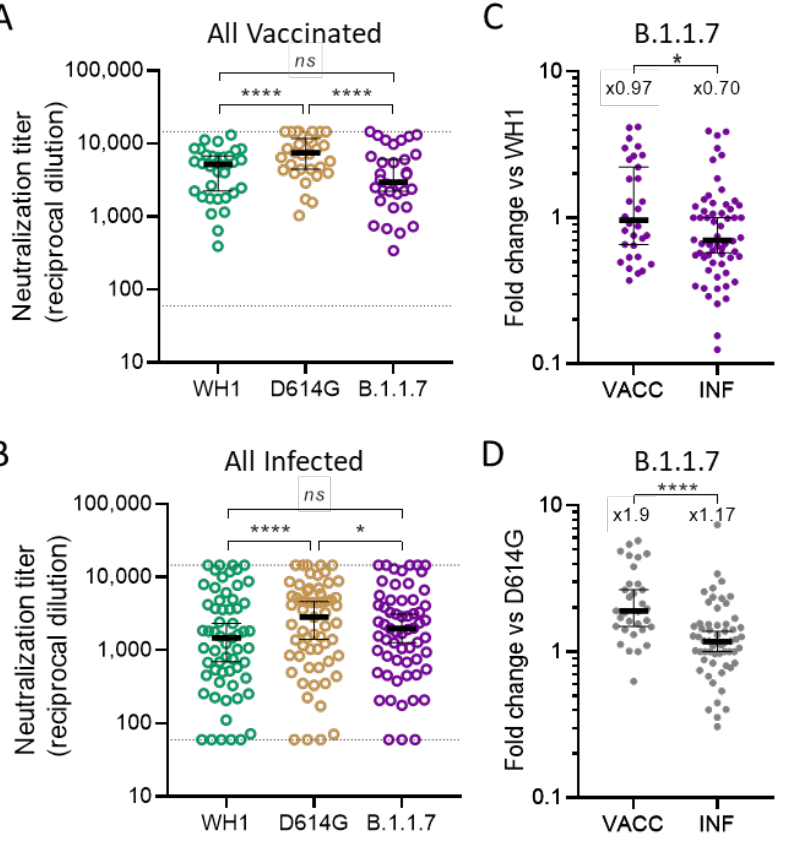
Figure 2. Global analysis of neutralization titers in SARS-CoV-2 vaccinated and infected individuals. Values of ID 50 (as reciprocal dilution) are shown for all plasma samples from ( A ) vaccinated and ( B ) infected non-vaccinated individuals against the indicated pseudoviruses. Bars indicate median titer in each group with a 95% confidence interval and p values show the comparison of median titers among the three viruses (Friedman test with Dunn’s multiple comparison test, * p < 0.05, **** p < 0.0001). The corresponding fold-change in neutralization titers between ( C ) WH1 and B.1.1.7 or ( D ) D614G and B.1.1.7 is shown (lower is better), comparing the vaccinated (VACC) and the infected (INF) groups. Bars indicate median in each group with 95% confidence interval and top values indicate the median fold-change between the indicated variants (variants compared are indicated in the graph title and in the Y axis). Fold change medians were compared using the Mann–Whitney test (* p < 0.05, **** p <